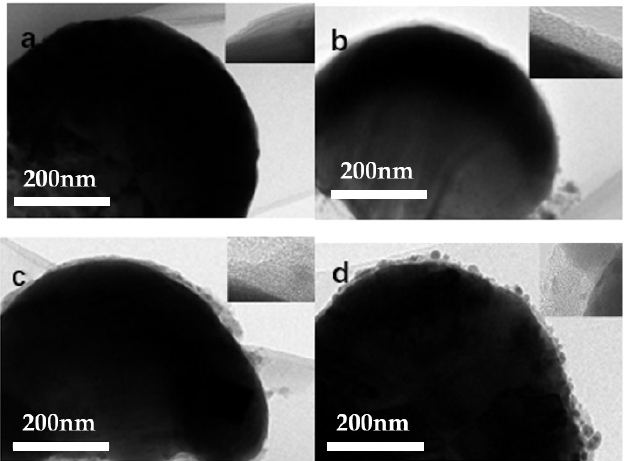
Figure 3. TEM images of Ag/ZnS (( a ) 0 min, ( b ) 5 min, ( c ) 10 min, ( d ) 15 min) films on PS beads. According to the Drude model, the plasmon frequency ( ω p ) shows the dependence on the electron density as expressed by Equations (1) and (2), which means that the changes in the free carrier concentrations results in the shift of the LSPR peak, where N e stands for the free electron density, m for the effective mass of the electron, and ε for the dielectric function [23].